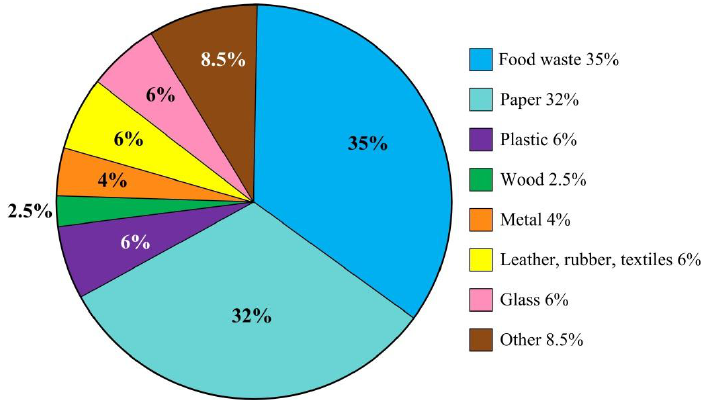
Figure 8. MSW structure of Novosibirsk region (No. 2).